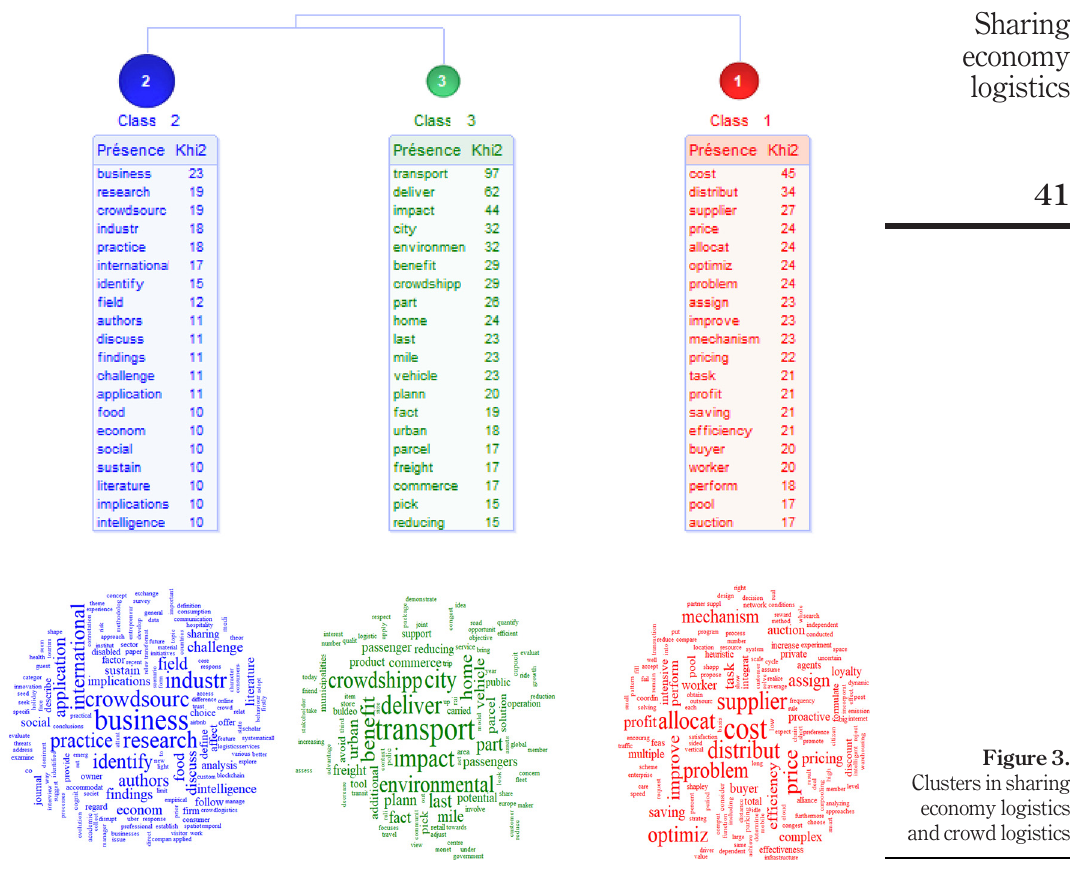
Figure 3. Clusters in